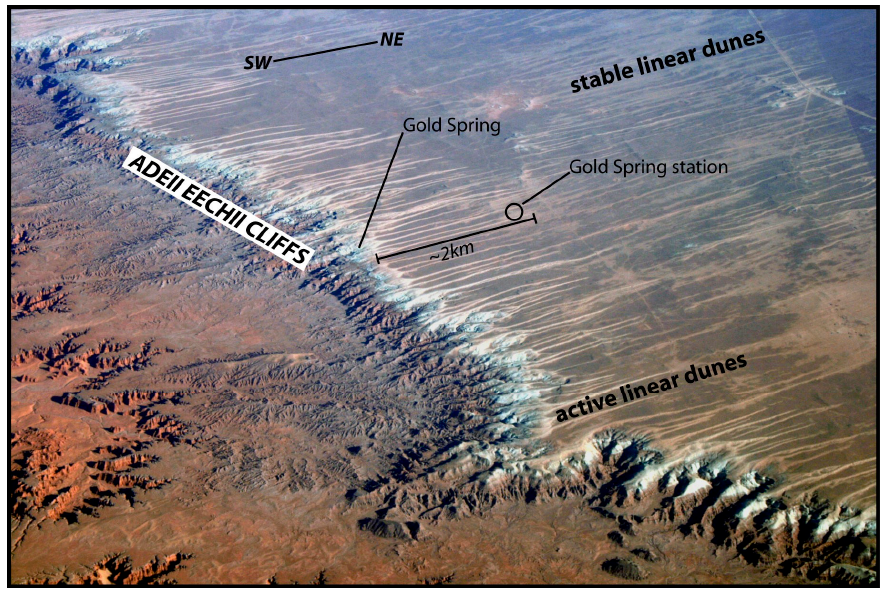
Figure 3. Aerial photo of the Adeii Eechii Cliffs escarpment, active and stable linear dune crests, and the location of the USGS Gold Spring station. Photo taken 22 March 2008, courtesy of Dr. Grant Meyer, University of New Mexico.